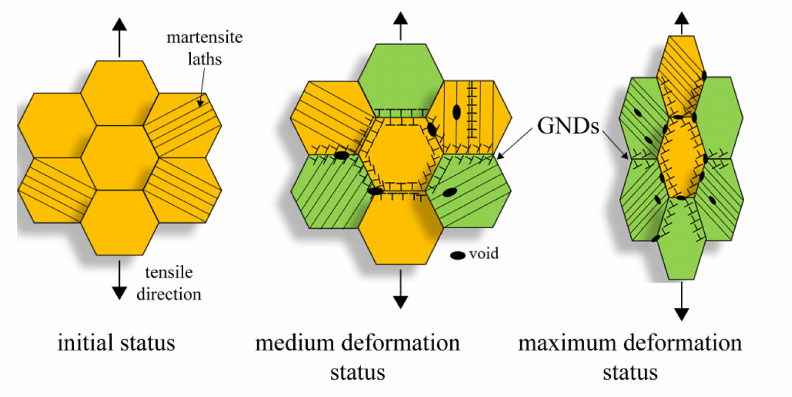
Figure 12. The schematic illustration of the deformation mechanics under the initial, medium, and maximum deformation for MarBN